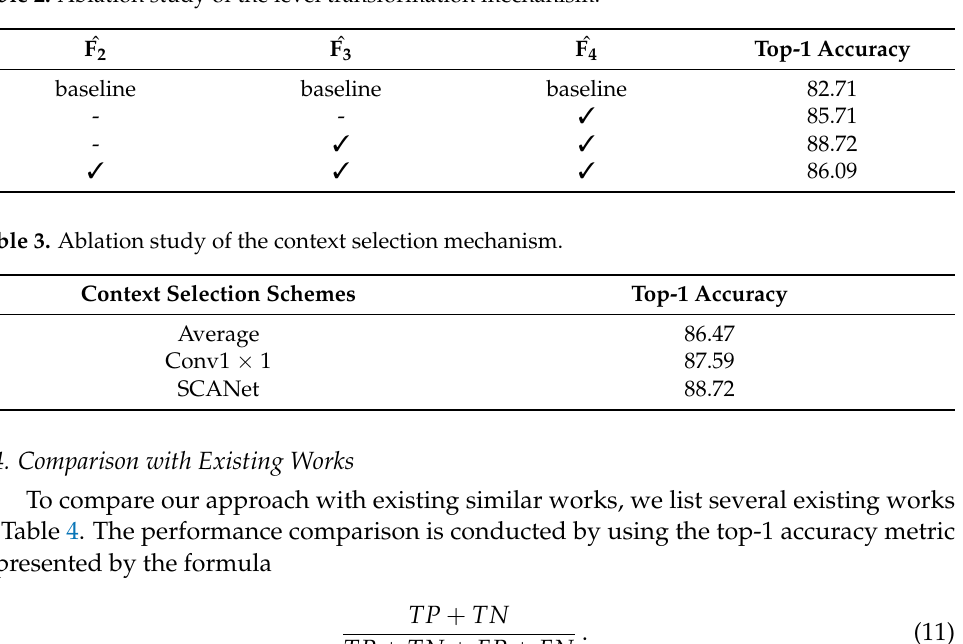
Table 2. Ablation study of the level transformation mechanism.